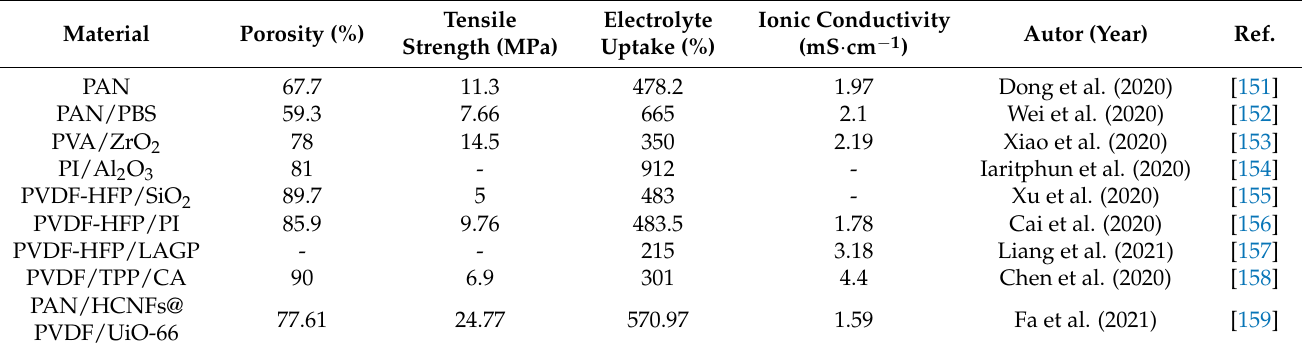
Table 3. Recent approaches toward fabrication of electrospun separator applicable in Li-ion